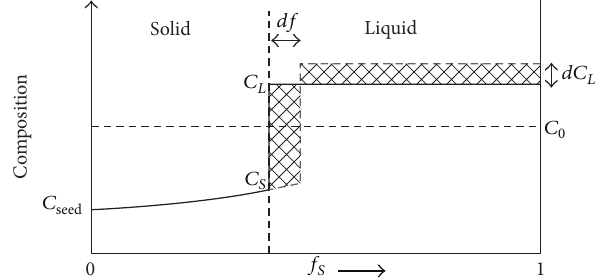
Figure 6: Diagram showing the derivation of the complete mixing